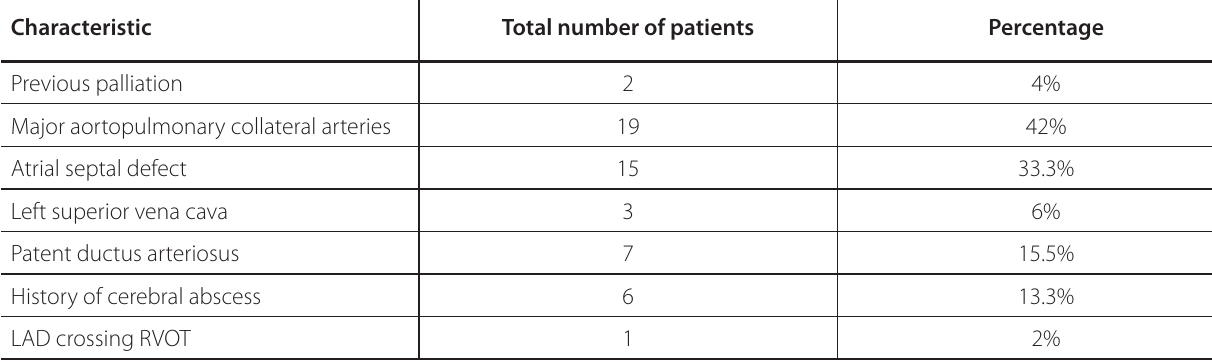
Table 1 . Preoperative characteristics of the patients included in study.